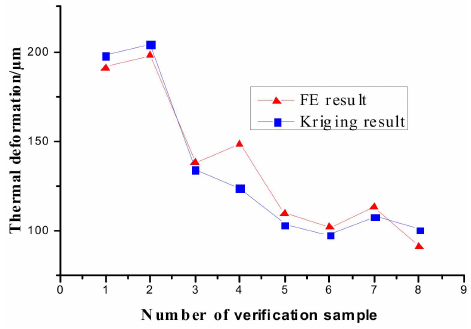
Figure 14. Comparison between the results obtained by di ff erent